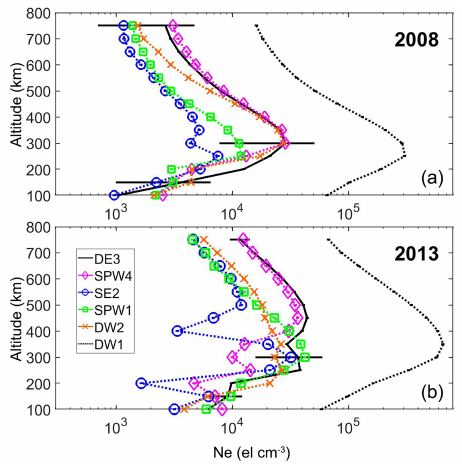
Figure 8. Amplitudes’ vertical profiles of some waves observed in Figs. 6 and 7. Panel (a) is related to amplitudes observed in the 2008 September equinox period, while (b) is related to those observed in the 2013 equinox period. The same waves’ signatures used in Figs. 3 and 5 were also considered here. DE3, SE2 and SPW4 are supposed to be related to the wave-4 structures in the ionosphere. SPW1 and DW2 are supposed to be related to the offset between the geographic and geomagnetic coordinates. The black horizontal bars on the DE3 plot represent the standard deviation calculated for some altitude